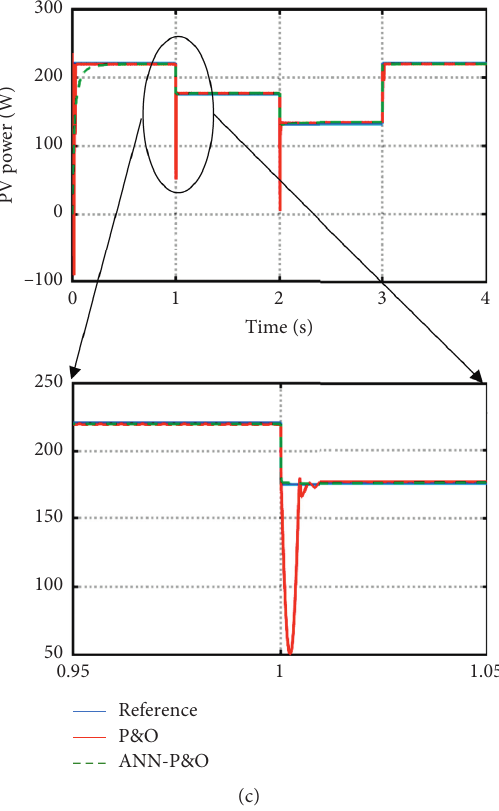
Figure 15: PV simulation responses under varying irradiance. (a) Current. (b) Voltage. (c)